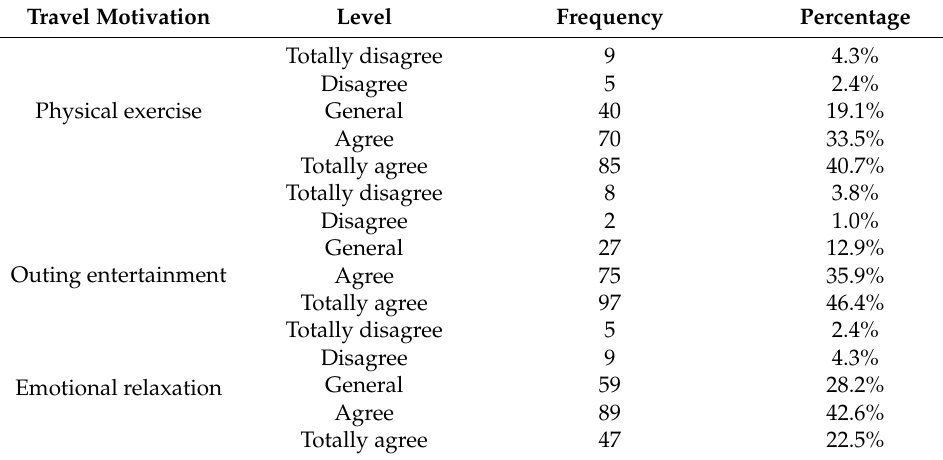
Table 4. Travel motivation information